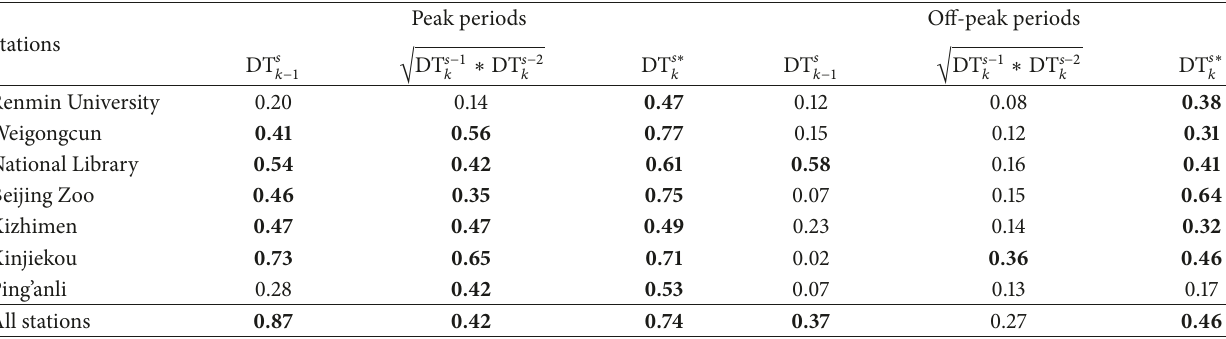
Table 12: Correlation coefficients of the predictors.